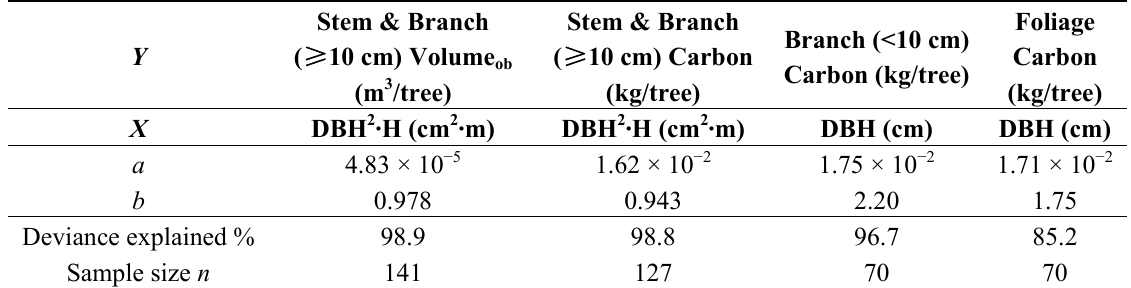
Table 2. Mixed-species allometric equations for estimating stem and large branch volume and component carbon for natural forest trees, sample size ( n ), and deviance